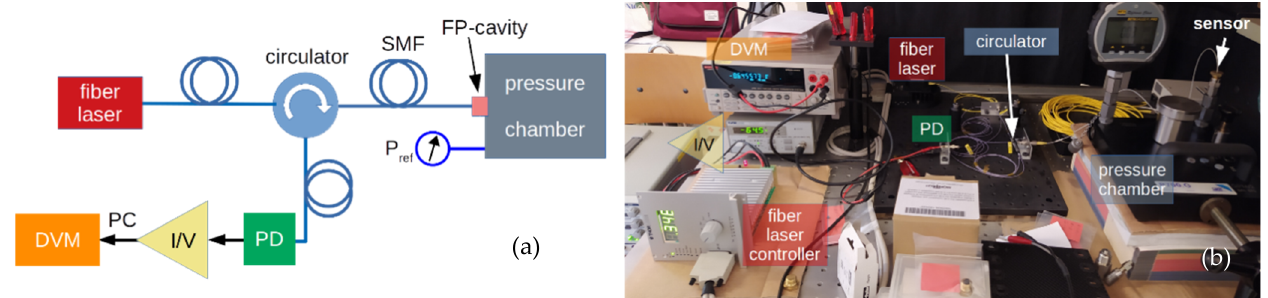
Figure 2. ( a ) Schematic (adapted from ref [41]) and ( b ) picture of the experimental set-up for the pressure sensor charac- terizations. An IR fiber-laser is coupled to the FP-cavity by means of a circulator. The interference signal is detected by a photodiode (PD). The photocurrent (PC) signal is acquired as a function of the pressure by a computer-controlled digital voltmeter (DVM) connected to the output of a current-to-voltage (I/V) amplifier.